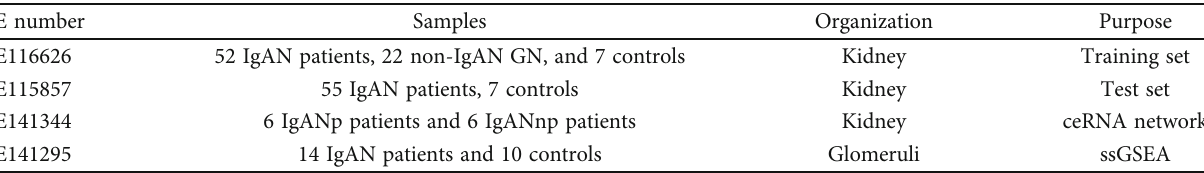
Table 1: The summary of those four GEO datasets.